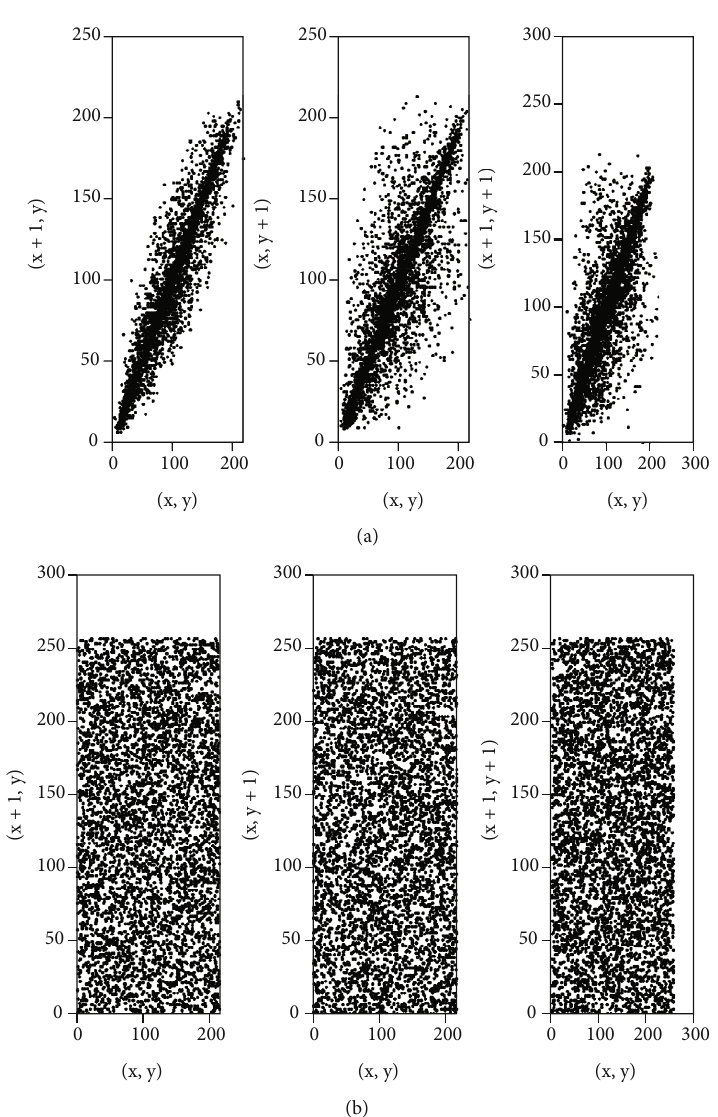
Figure 8: Correlation analysis of Barbara. (a) Correlation analysis of plaintext. (b) Correlation analysis of